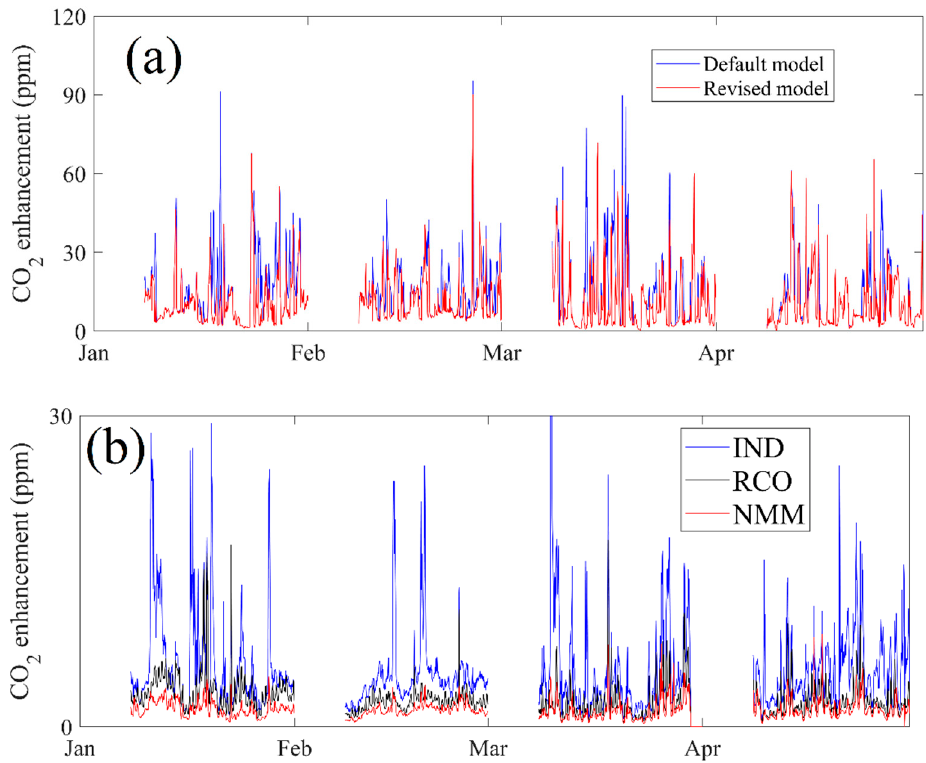
Figure 5. ( a ) Time series of CO 2 enhancements from ENE (power stations) by using default model framework and revised framework, ( b ) CO 2 enhancement contributions from IND (manufacture industry), RCO (energy for building), and NMM (cement production).